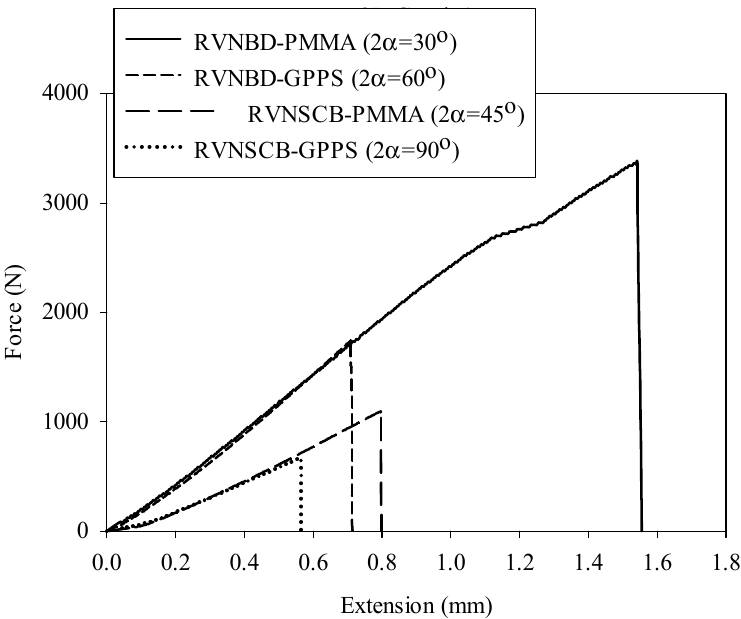
Figure 3. Typical force–displacement curves obtained from the RVNBD and RVSCB polymeric specimens with R = 35 (mm). Table 2. The fracture loads of polymeric (PMMA and GPPS) CBD and SCB samples at various scales (dimensions in mm, load values in N).